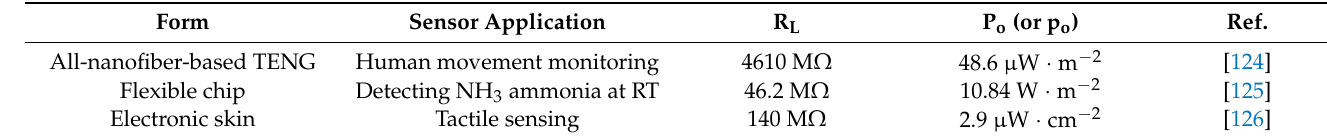
Table 9. Comparison of various